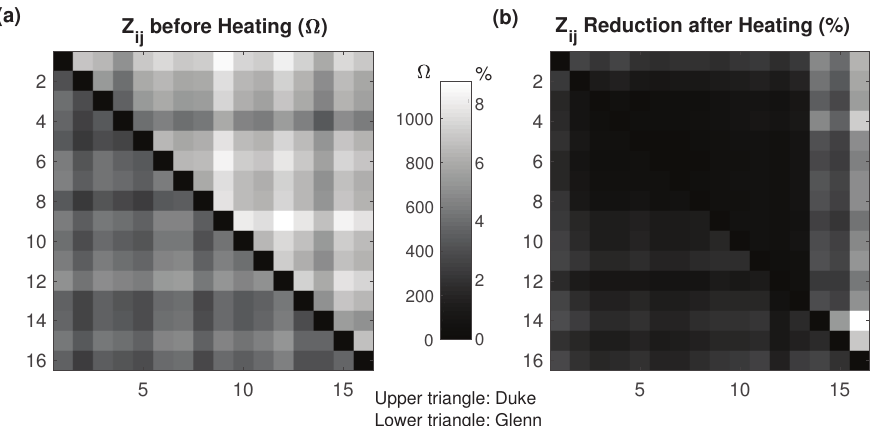
Figure 13. ( a ) Preheating impedance Z ij per electrode pair (in Ω ) and ( b ) impedance reduction due to heating (in %). Upper and lower triangle values correspond to the Duke and Glenn anatomical models, respectively. The numbering follows Figure 2.